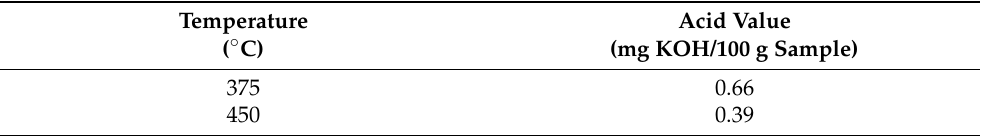
Figure 3. GC-FID chromatogram at different temperature ( A ) and hydrocarbon component of liquid products from pyrolysis of unsaturated fatty acid ( B ). Table 3. Acid value of M-mix soap pyrolysis liquid